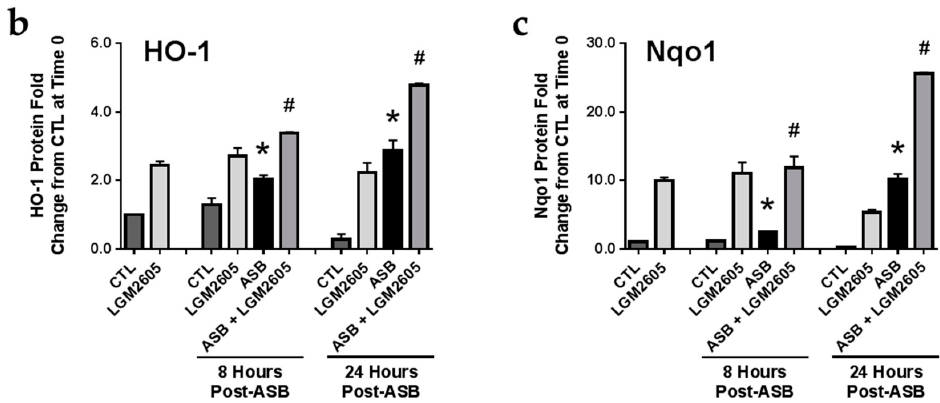
Figure 7. The Synthetic Lignan SDG (LGM2605) Enhances the Expression of Nrf2-Regulated Antioxidant Enzymes in Elicited Murine Peritoneal Macrophages. Levels of antioxidant enzymes were determined by ( a ) Western blotting for HO-1 and Nqo1; Densitometric analysis of band intensity for ( b ) HO-1 and ( c ) Nqo1 was normalized to β -actin and values are expressed as fold change from CTL at time 0. Data are presented as mean ± SEM. * indicates a statistically significant difference ( p < 0.05) between ASB and CTL treated cells; # indicates a statistically significant difference ( p < 0.05) between ASB and ASB + LGM2605 treated cells.